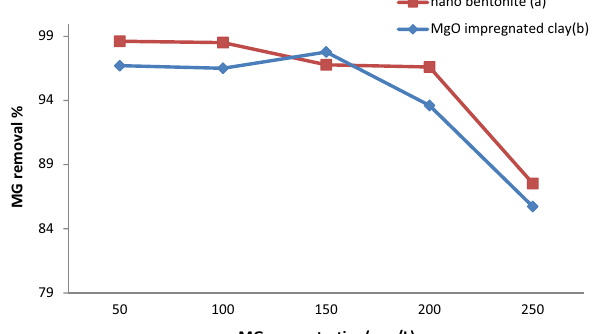
Figure 9. Effect of initial MG dye concentration on MG dye removal by ( a ) nano bentonite and ( b ) MgO impregnated clay.